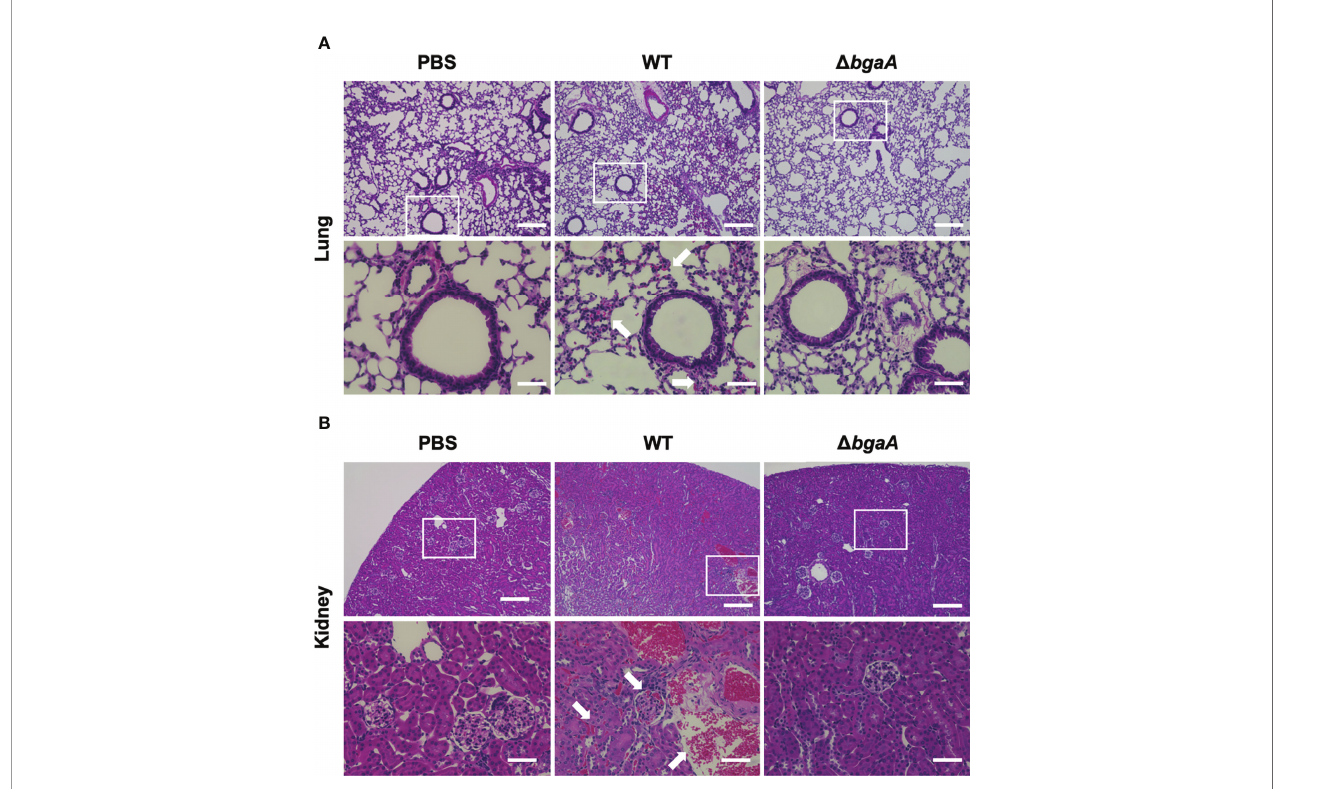
FIGURE 3 | De fi ciency of bgaA decreases bleeding and microthrombus formation in mouse organs. Haematoxylin and eosin staining of infected mouse lungs (A) and kidneys (B) collected at 36 h after intravenous infection with PBS or S. pneumoniae TIGR4 WT or D bgaA strains. Arrows indicate bleedings and/or microthrombus formations. Scale bars are 200 µm (upper panels) and 40 µm (lower ( Supplementary Figure 2 ), no signi fi cantly different cytokines and chemokines were observed between WT- and D bgaA- infected mice at 24 h and 36 h. These results indicate that BgaA de fi ciency activates host innate immunity pathways at the RNA level but not the protein level.